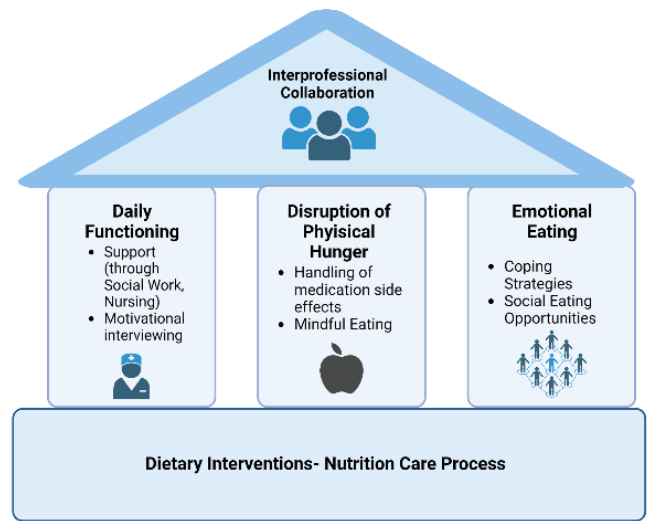
Figure 2. Future interventions to improve dietary behavior focused on interprofessional collaboration. Figure created with BioRender.com.